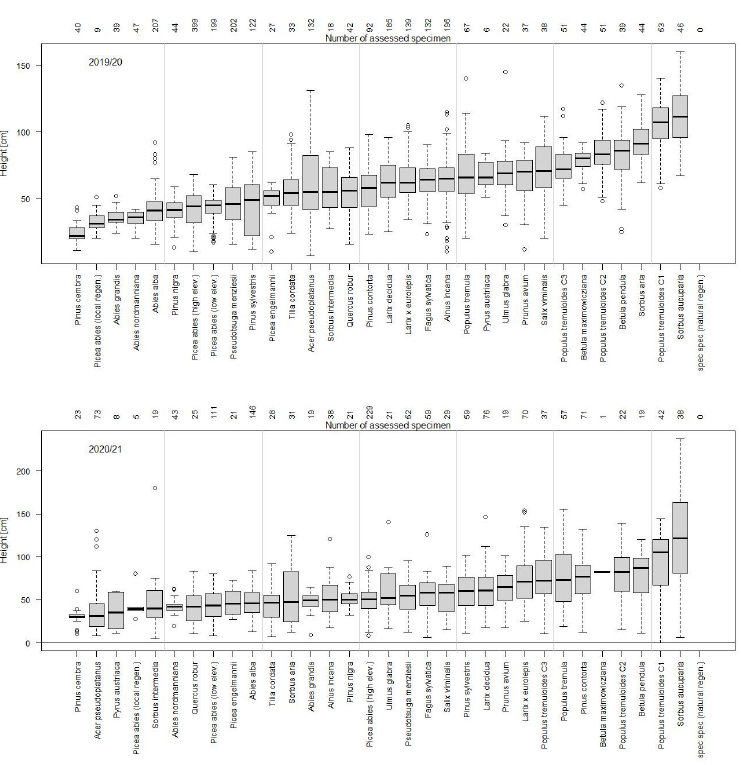
Figure 4. Height of trees in the reforestation experiment site, Wechsel, in 2019 and 2020. The number of assessed seedlings is shown at the top.